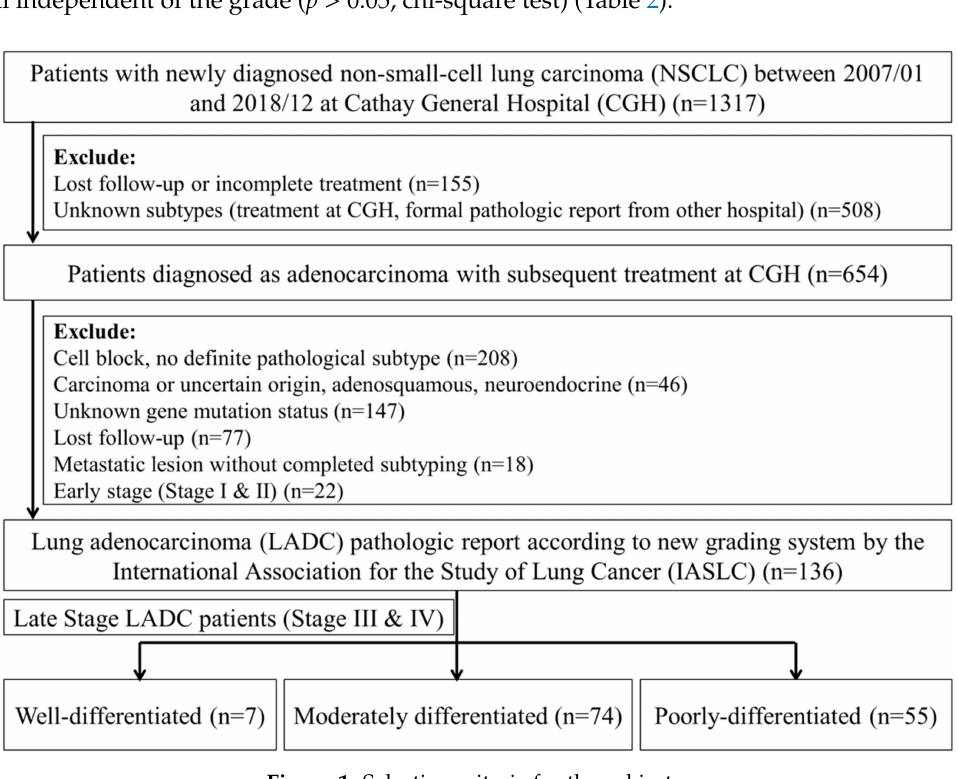
Figure 1. Selection criteria for the